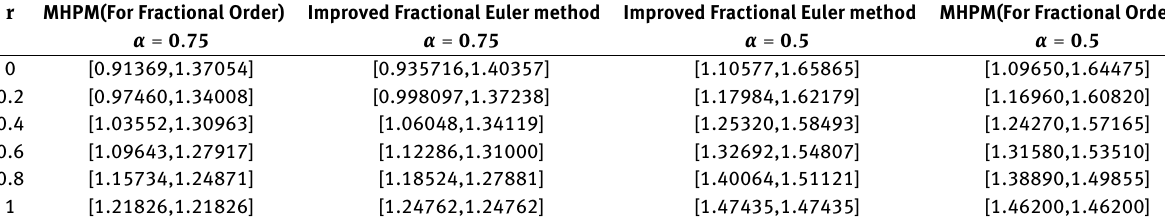
Table 2. Solutions obtained by MHPM and IFEM for h = 0.01 at t = 0.1 for different values of α . r MHPM(For Fractional Order) Improved Fractional Euler method Improved Fractional Euler method MHPM(For Fractional Order) α = 0 . 75 α = 0 . 75 α = 0 . 5 α = 0 .